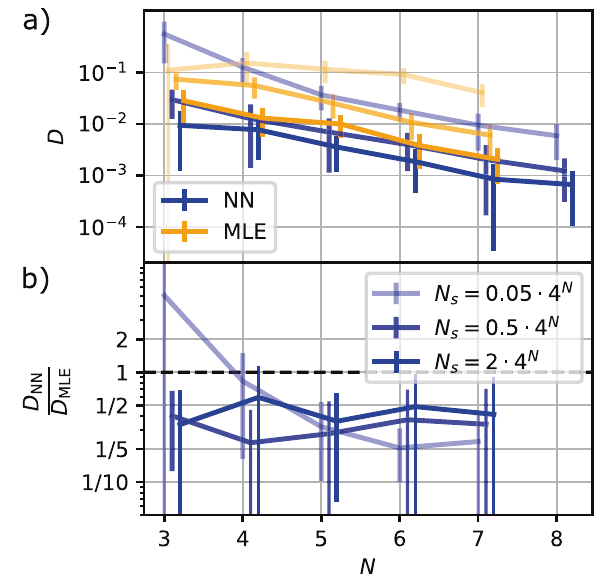
Fig. 2 Tomography of 1D Ising groundstates: NN vs MLE. a Residual classical in fi delity of CCNN and MLE on 1D Ising ground state with periodic boundary conditions, J / B = 1. Shown for different dataset sizes N s . b Residual network in fi delity normalized to residual MLE in fi delity. Error bars are standard deviations across multiple independent tomography datasets and neural network training runs with randomly initialized parameters.